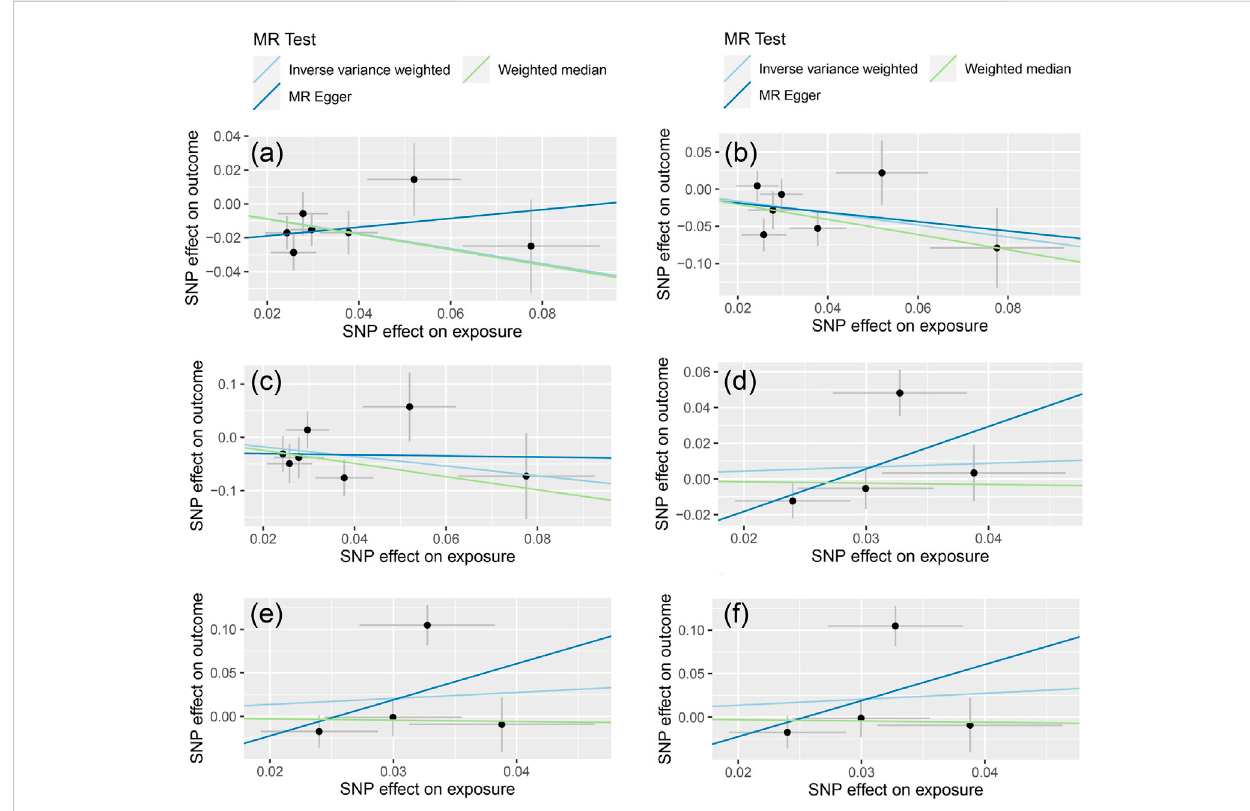
The results of MR-Egger regression [The (A – C) represent the causal in fl uence of light PA on COVID-19 susceptibility, hospitalization, and severity respectively,the (D – F) representthecausalin fl